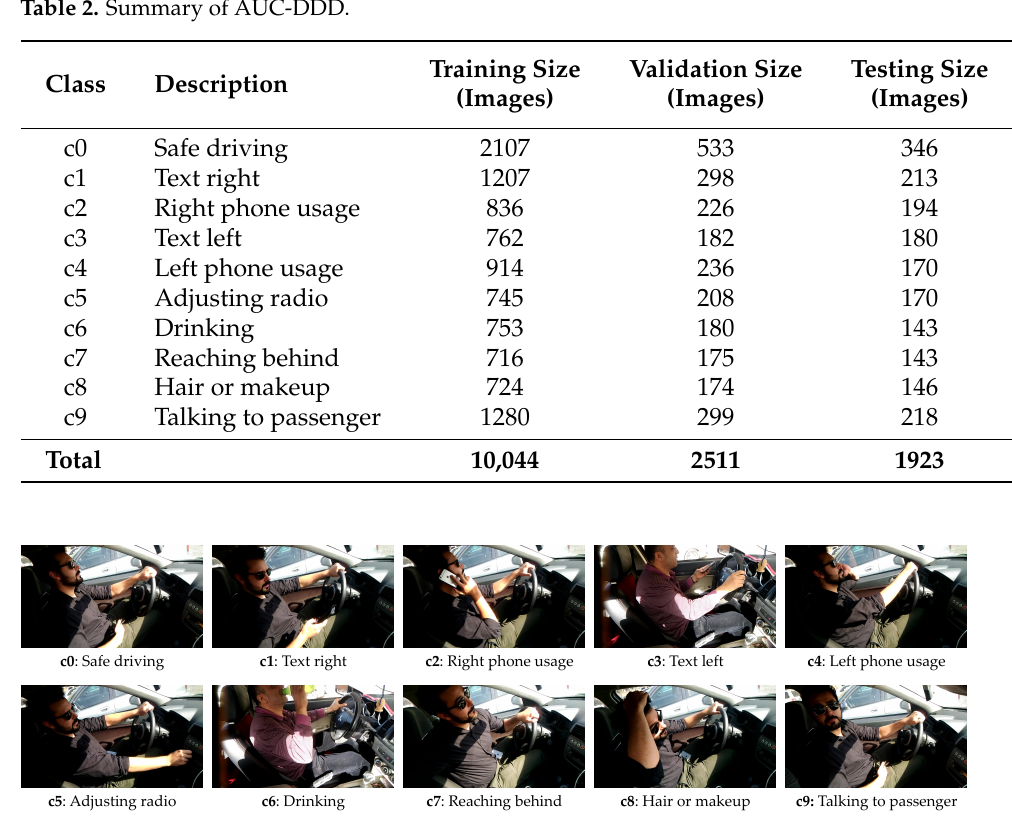
Figure 3. Sample image from each